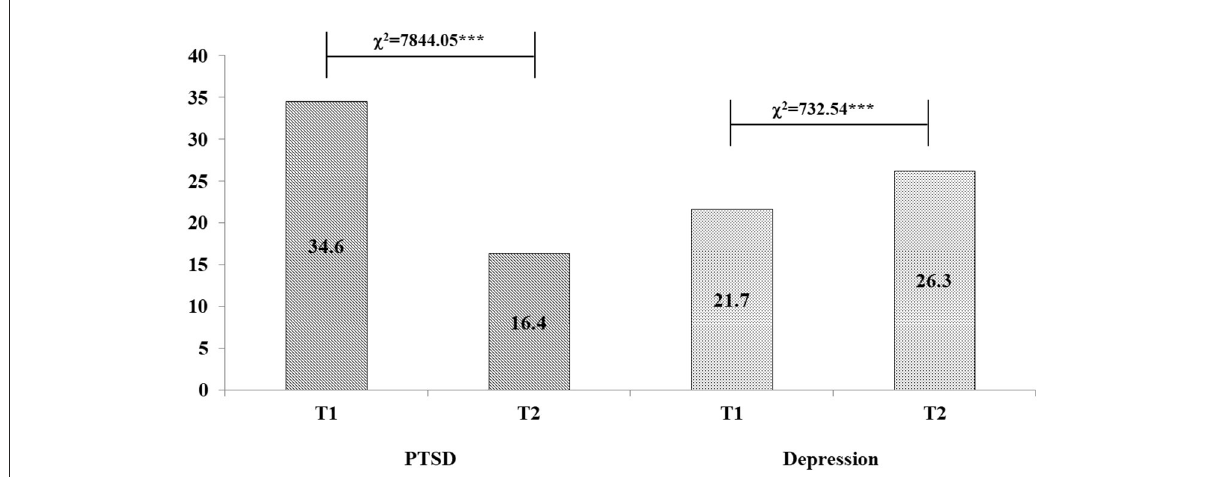
FIGURE2 Prevalence rates of PTSD and depression at two follow-ups (%), *** p <